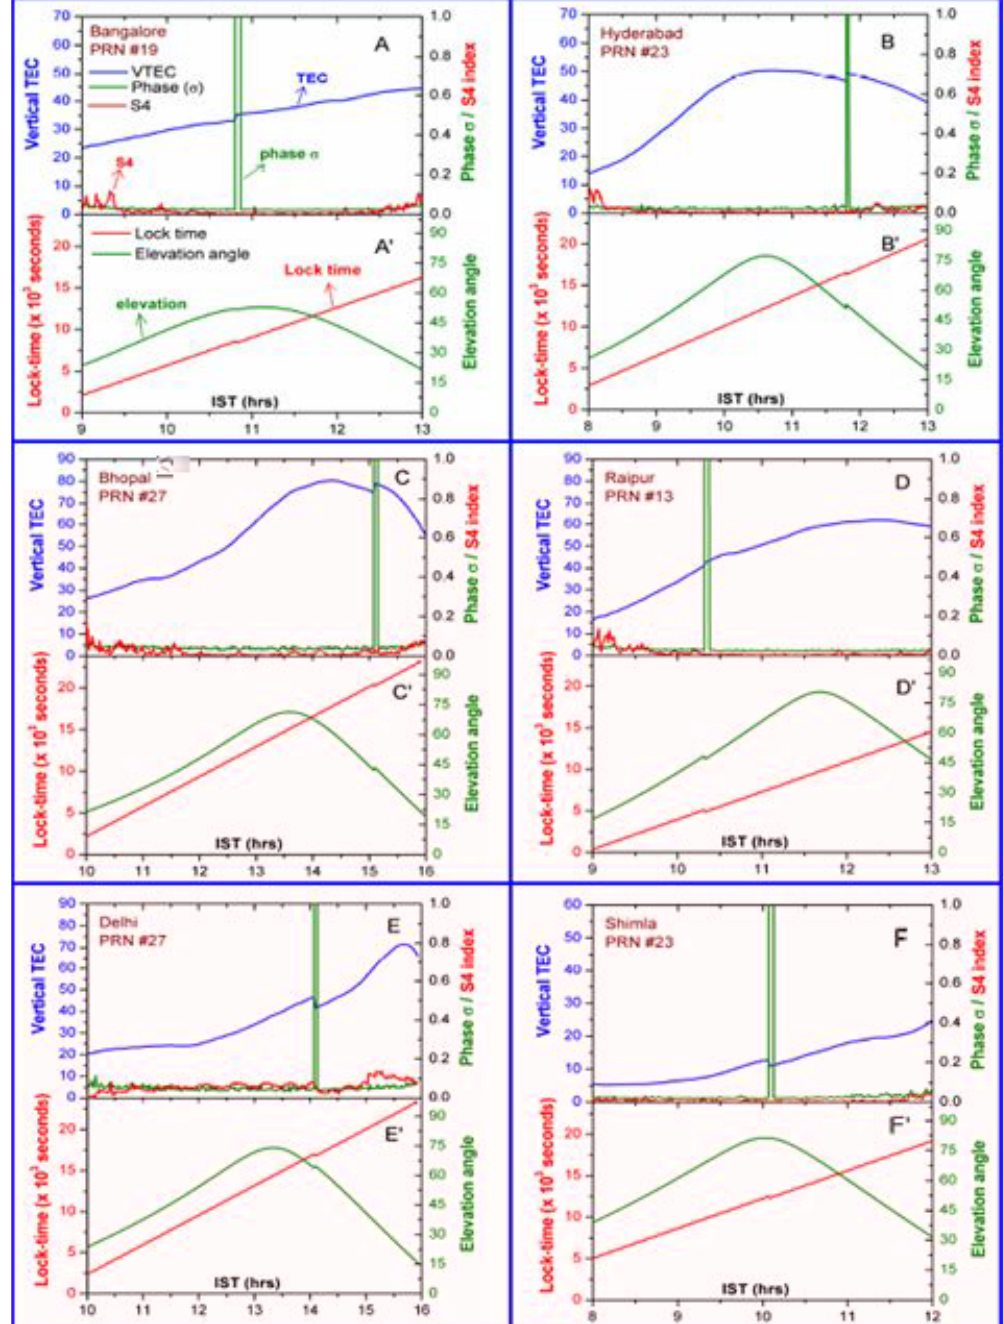
Fig. 4. Phase slips ( σ) observed in the GPS receivers during a quiet day, 6 November 2004, presented along with the corresponding S4 index, TEC and lock time on different satellite passes at the six different locations situated along the common meridian 77 ◦ E